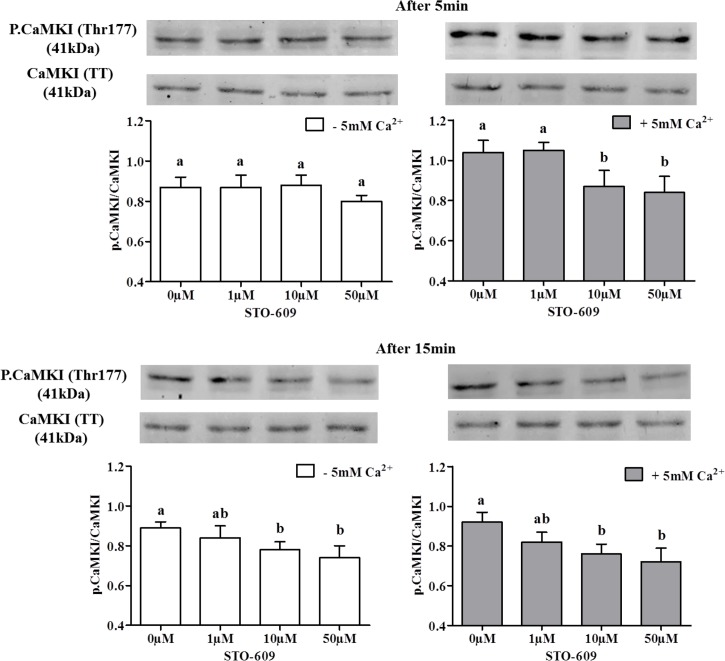
Effects of STO-609 on the CaMKI phosphorylation in chicken sperm.Sperm incubated at 35°C in the –5mM Ca2+ or +5mM Ca2+ medium with or without CaMKKs inhibitor STO-609 (0; 1; 10; 50 μM) at 5 min and 15 min. The control (Ctrl): sperm incubated with or without Ca2+ in the absence of STO-609. Proteins from sperm lysates were analyzed by western-blotting using anti-phospho-Thr177-CaMKI or anti-CaMKI as the primary antibody. Bands for phospho-Thr177-CaMKI were detected at 41kDa (top lanes). Total CaMKI (41kDa) was used as loading control (bottom lanes) and the phosphorylated protein CaMKI (Thr177)/total CaMKI ratio is shown at the bottom. Results express the mean ± SEM of the mean from 4 different experiments. Different superscripts indicate statistically significant differences (P<0.05).